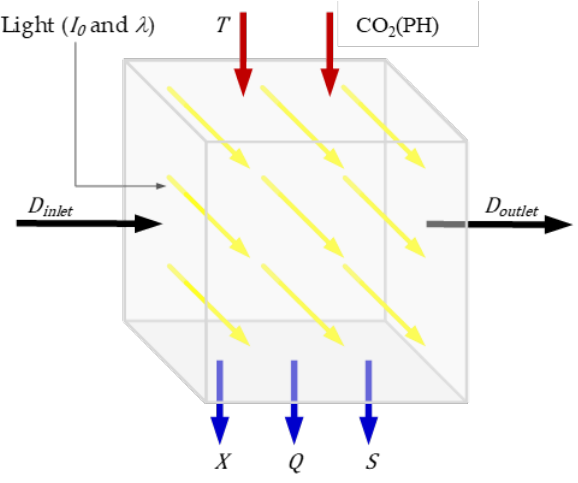
Figure 1. Conceptual Microalgae Culture in a Photobioreactor.